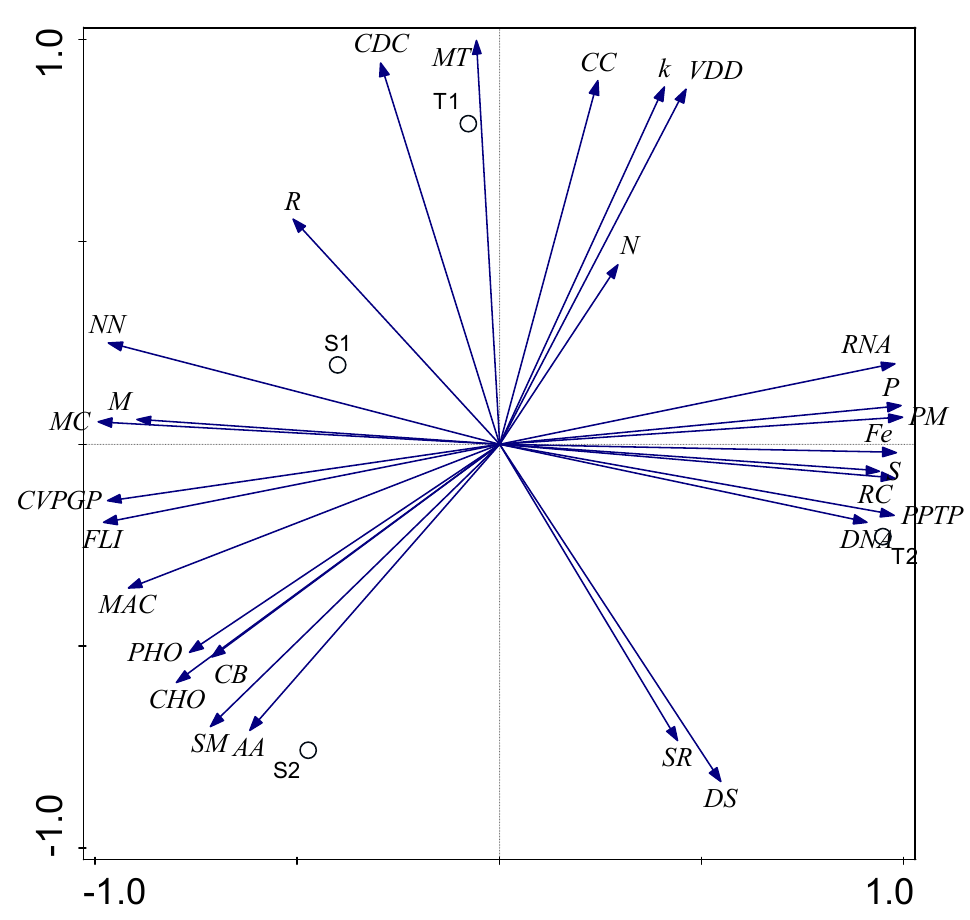
Figure 3. PCA of Functional analysis of bacterial metagenomes. The length of the vectors represents the strength of influence of the particular metabolic process. Axis 1 and axis 2 explained 86.1% and 11.47% variation, respectively.